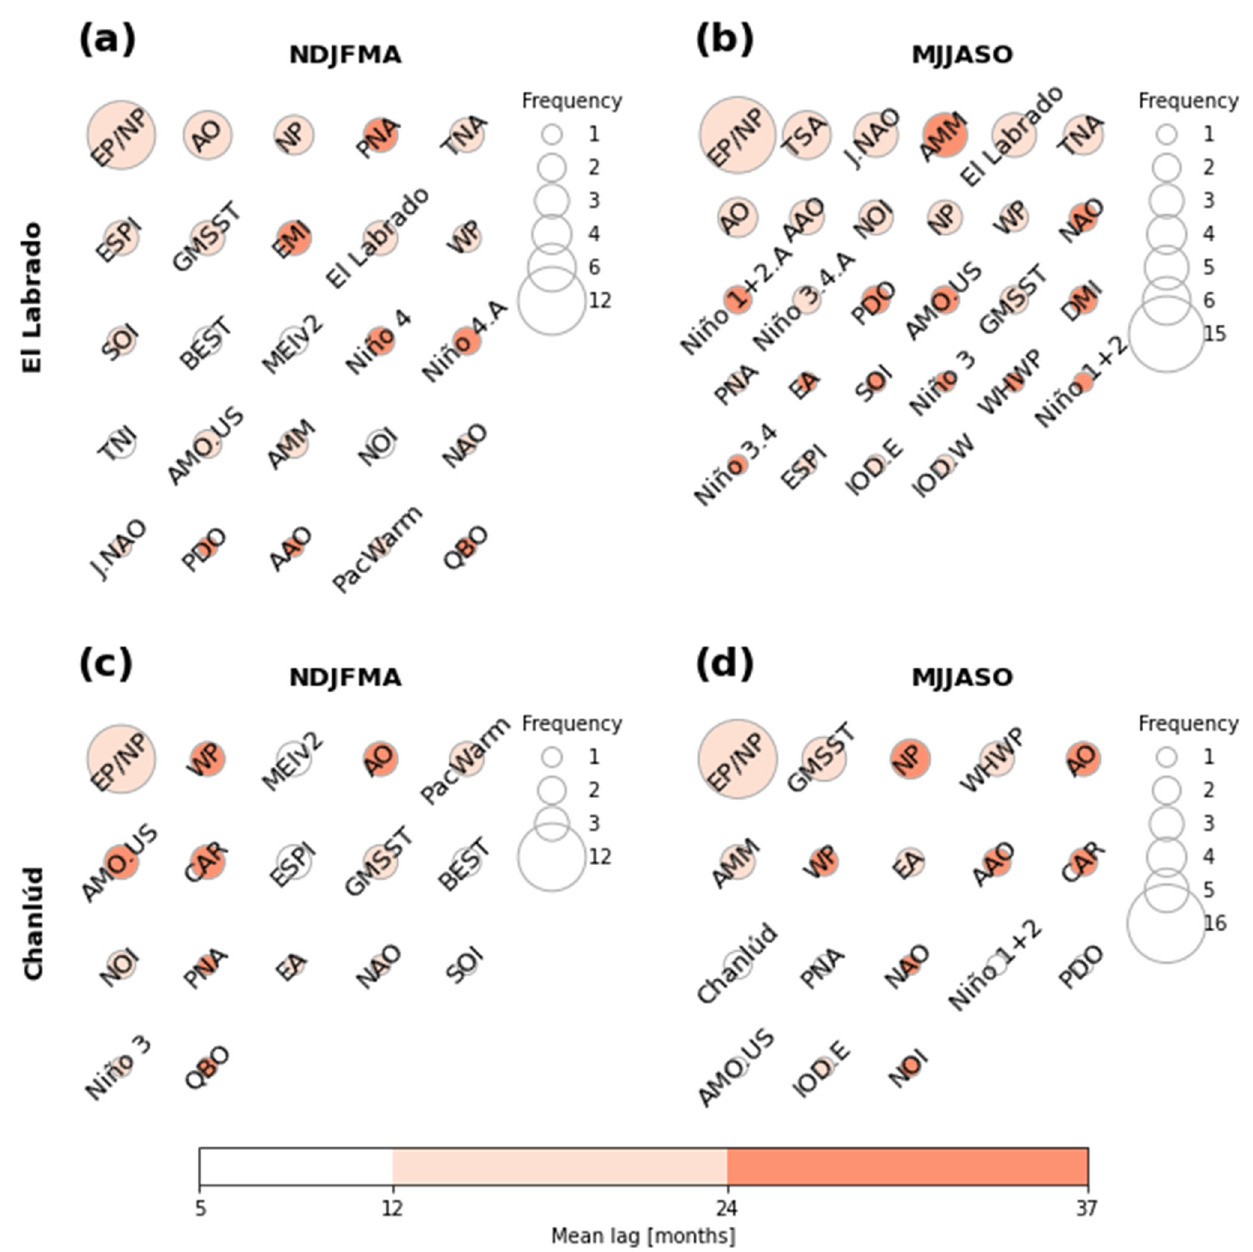
Figure 7. Predictors selected by means of SFS for each semiannual model. ( a , b ) Models for El Labrado (dots in Figure 4b); ( c , d ) models for Chanlúd (dots in Figure 4e); ( a , c ) semester November– April; ( b , d ) semester May–October. The size of each circle corresponds to the frequency with which a climate index (with different lags) appears as a predictor of the model. The color of each circle corresponds to the mean of the lags with which a climate index appears as a predictor of the model.